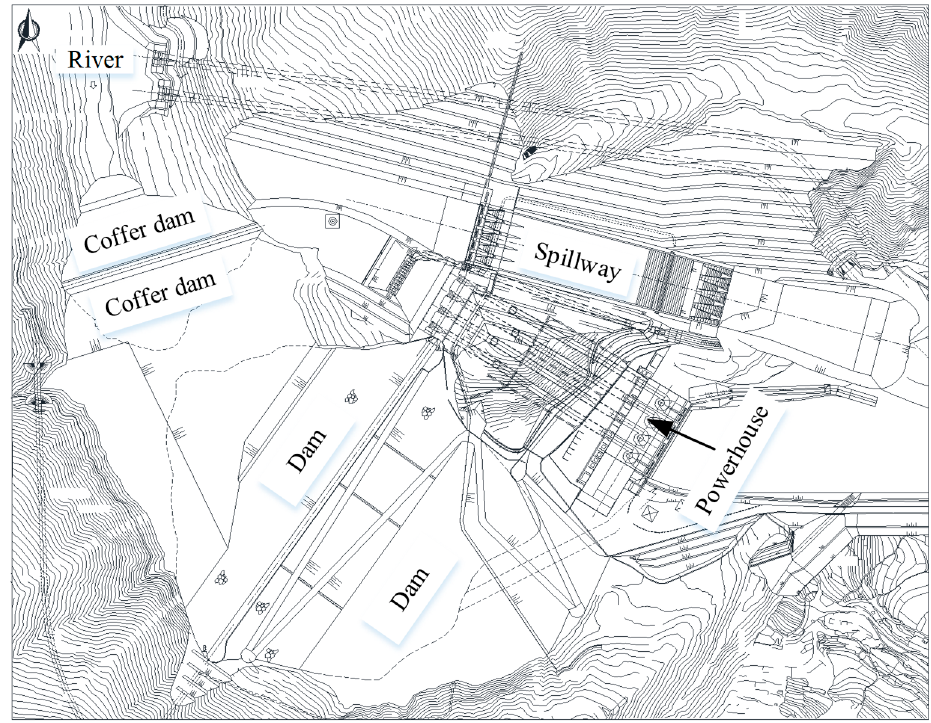
Figure 5. Details of a hydropower station in southwest China.